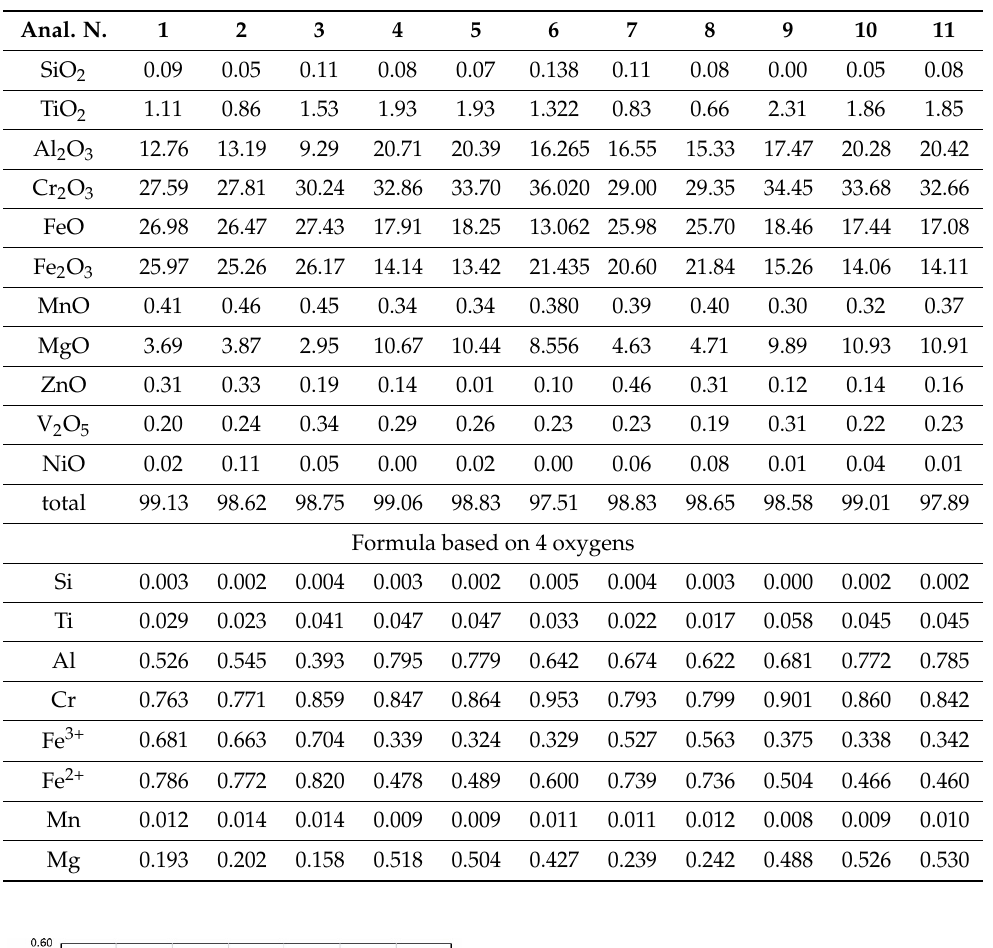
Table 6. Selected analyses of spinels.